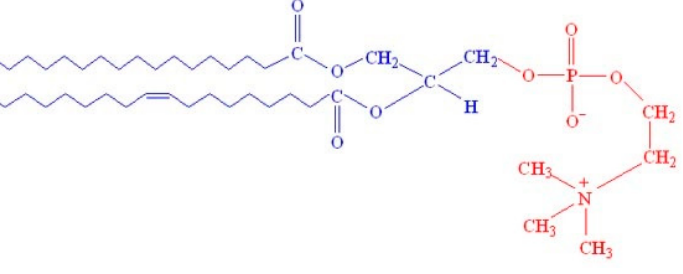
Scheme 2. Chemical structure of phosphatidylcholine